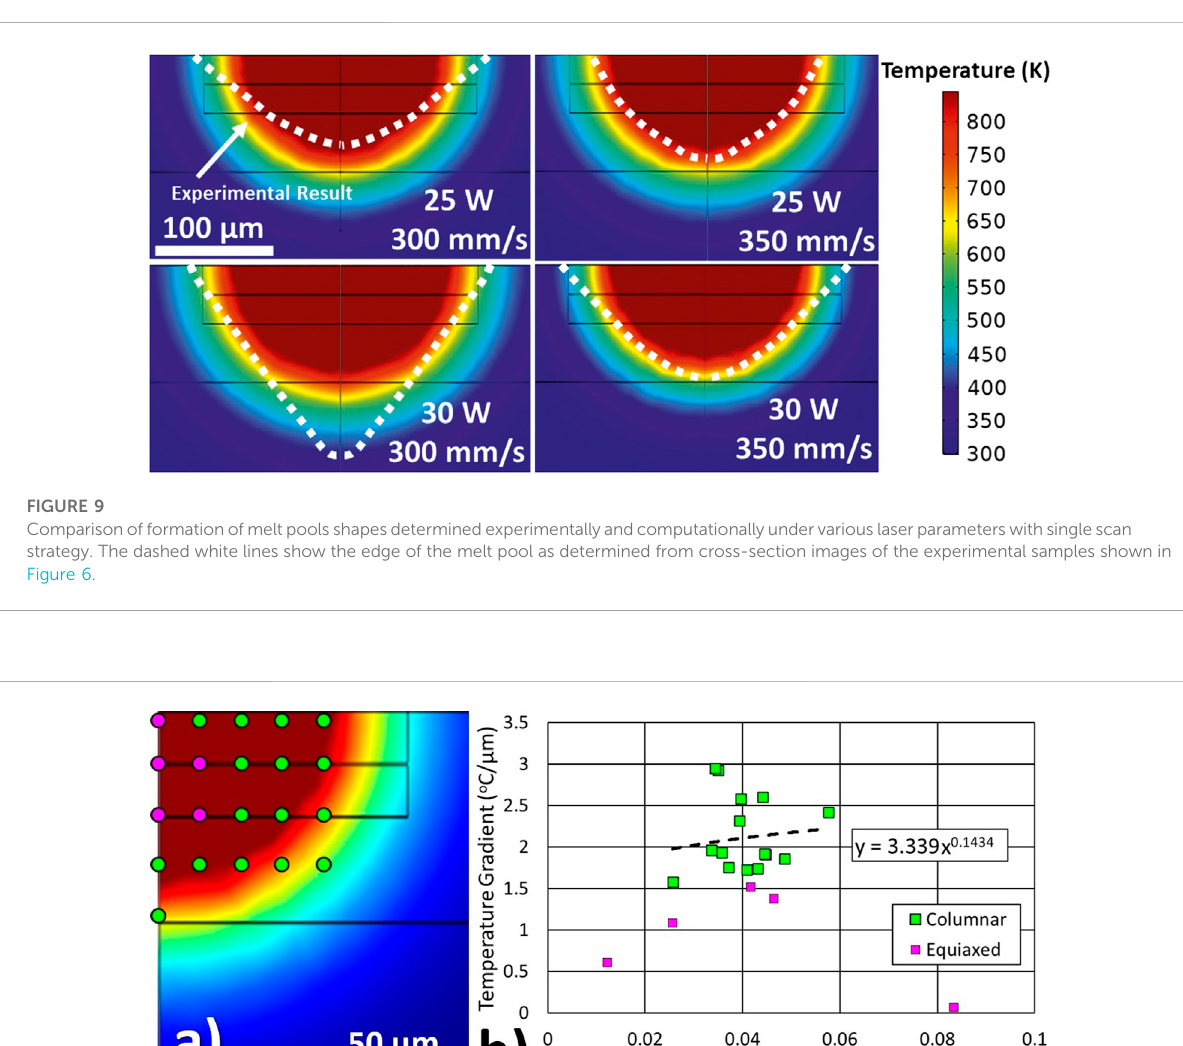
where C st is the limit where columnar to equiaxed transition occurs, and n is the power index of the temperature gradient function. By fi tting the curve in Figure 10B, n and C st have been calculated as 6.97 and 4.48 × 10 3 . In other words, the columnar to equiaxed transition will occur when G / R 0 . 143 exceeds 3.34.